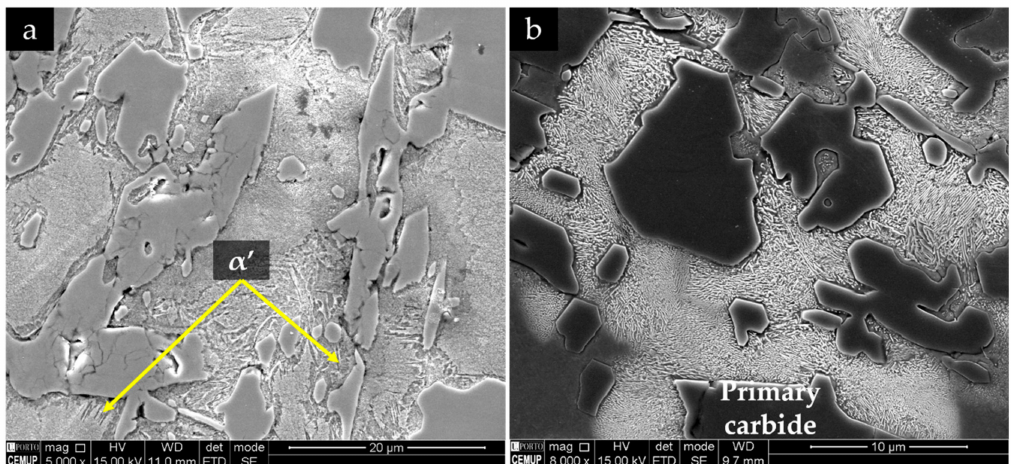
Figure 9. SEM-SE image of the microstructure of the high-chromium white cast iron in the as-cast condition at di ff erent magnifications.